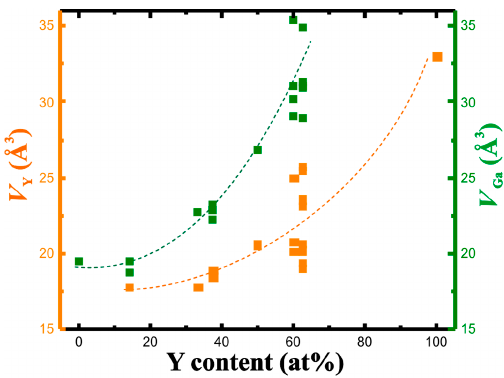
Figure 3. QTAIM charges of yttrium (orange) and gallium (green) in the Y-Ga compounds in dependence on the yttrium concentration. Dashed lines are eye-guides only.